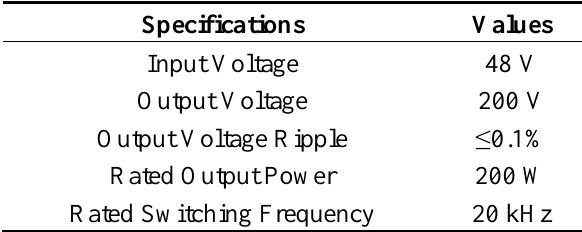
Table 1. Specifications of the proposed